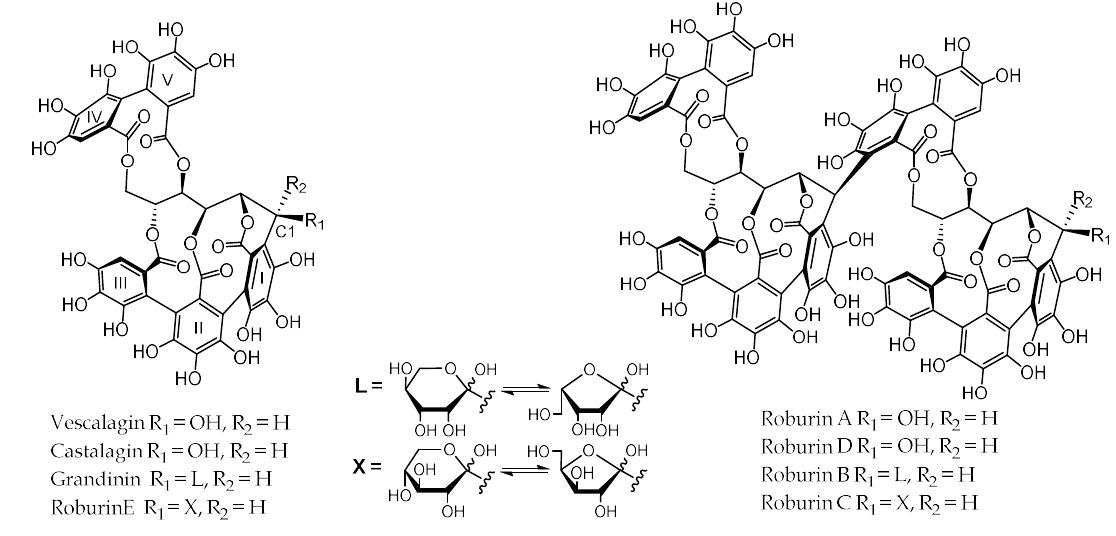
Figure 1. Ellagitannin structures.